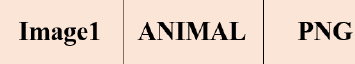
Figure 3. Node Representation of a record in uCLUST